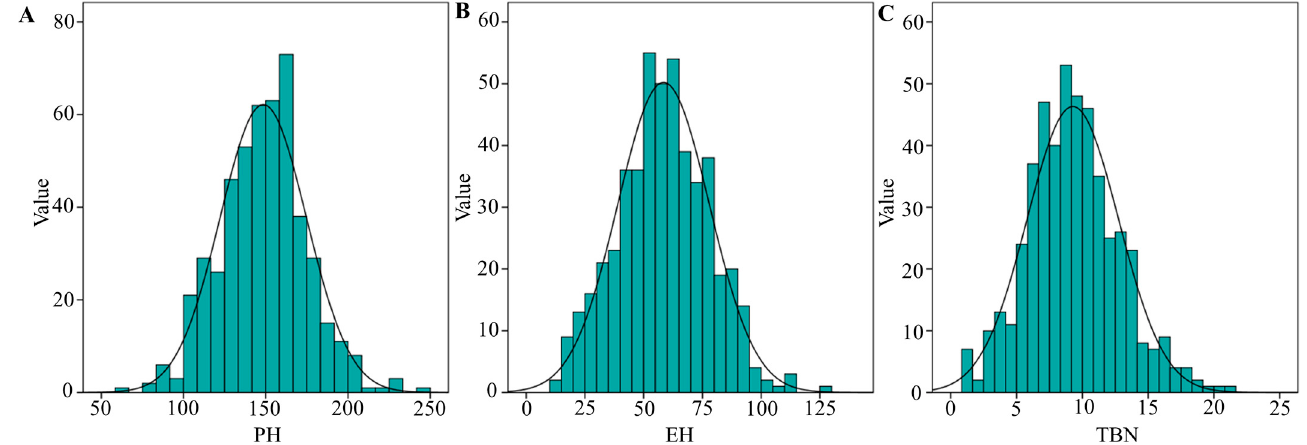
Table 1. Descriptive statistics, variance components, and broad-sense heritability (H 2 ) response to PH, EH, TBN in the population.